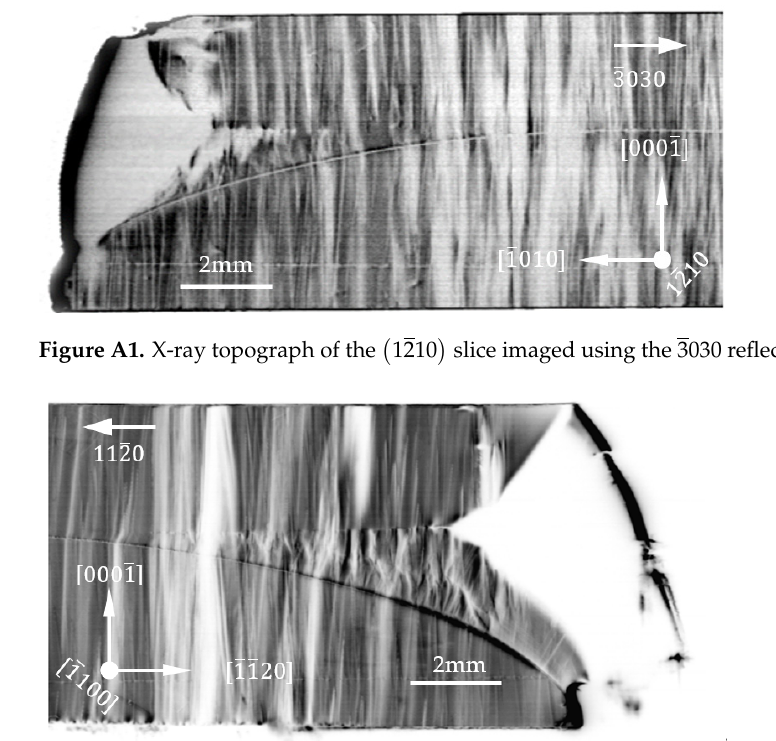
(cid:0) (cid:1) 1100 slice imaged using the 1120 reflection (Cu-K α 1